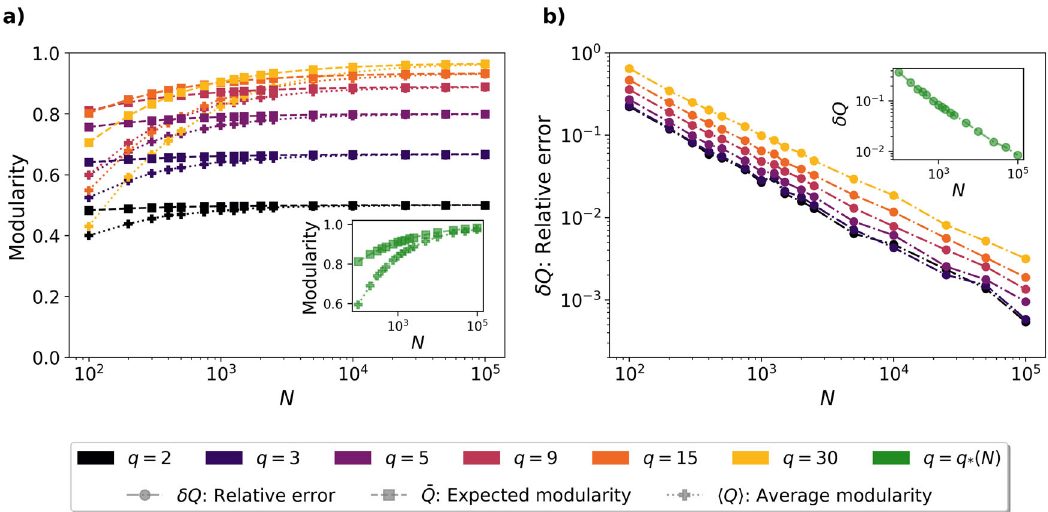
Fig. 2 The measured and the predicted modularity values in PSO networks along with the relative error of the prediction as a function of the network size N . The colours indicate the number q of equally sized communities into which the networks were divided. The examined PSO networks were generated with parameters m = 2, β = 0.6 and T = 0.1. In panel a , we show both the theoretical prediction for the expected modularity (cid:1) Q ð q Þ along with the exact modularity Q ( q ) averaged over the studied PSO networks. Panel b depicts the relative error of the prediction, which is de fi ned as δ Q ¼ ½ (cid:1) Q ð q Þ (cid:2) h Q ð q Þi(cid:6) = h Q ð q Þi . The number of samples considered in h Q ð q Þi decreases with the number of nodes N from 10000 at N = 10 2 to 50 at N = 10 5 . In both panels, the inset shows the corresponding curves at the optimal ( N -dependent) q * value, where the expected modularity is